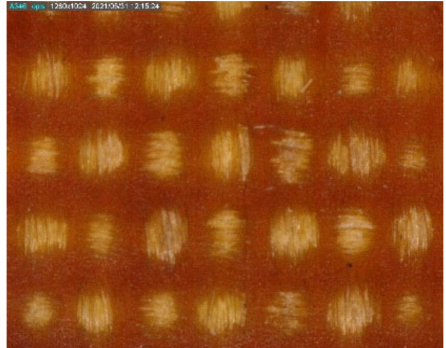
Figure 9. MO image of the surface of the textolite material with advanced degradation effects (40 times magnification). Significant carbonisation of the organic binder of the sample material occurred. Numerous bright fibre bundles of the textile support are visible. After the top layer of the resin had melted, the fibre bundles were found on the laminate